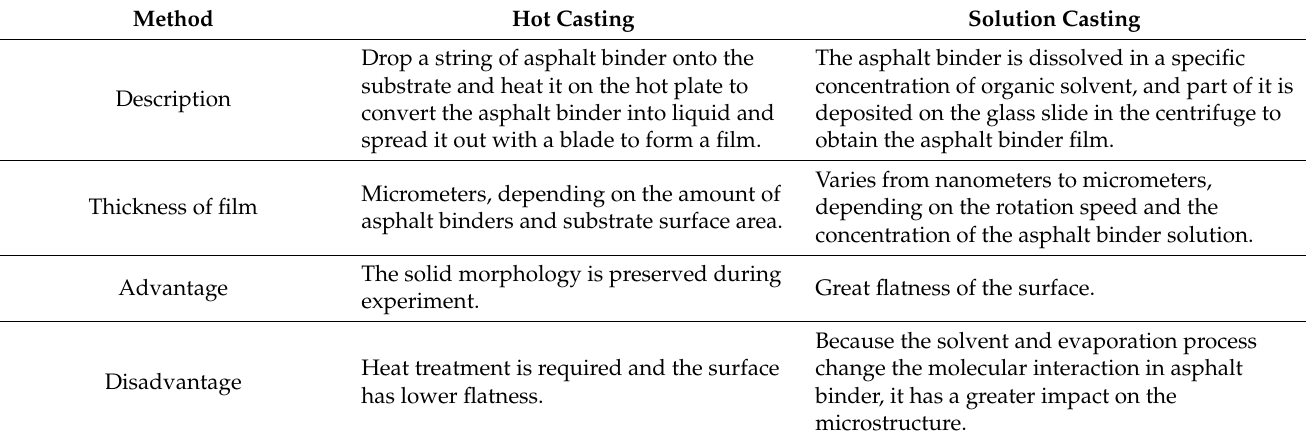
Table 2. The difference between the two AFM sample preparation methods [56,77,78].